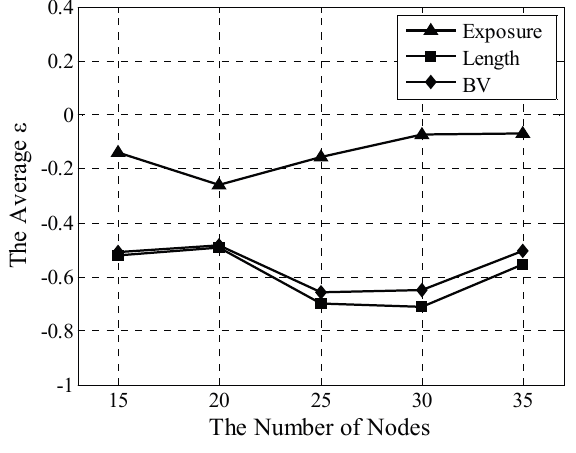
Figure 8. Averaged ε analyses for TES in multistage heterogeneous